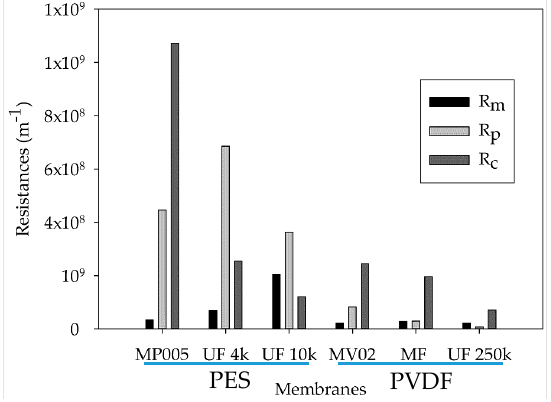
Figure 2. Membrane, pore, and cake resistances of the membranes.